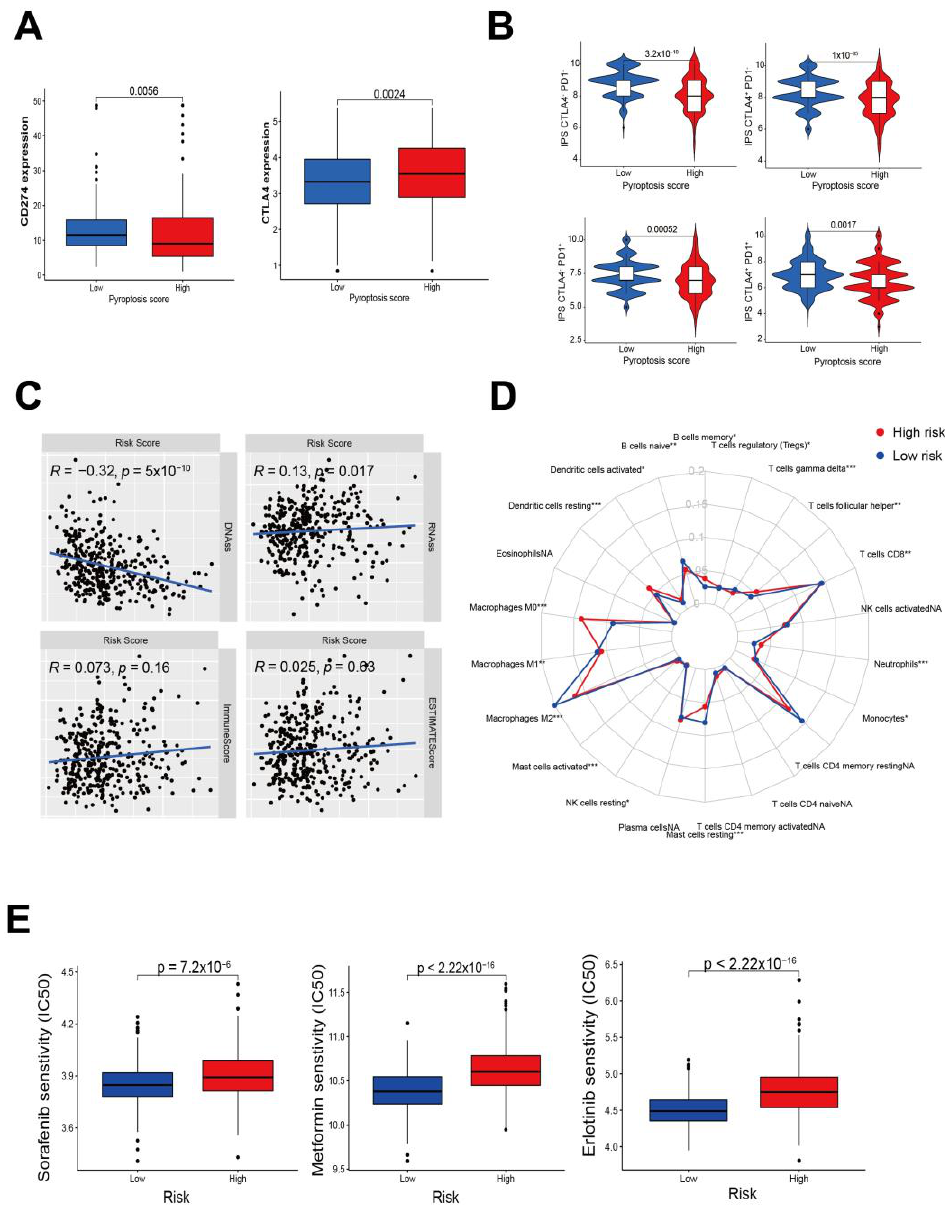
Figure 8. Pyroptosis risk scores in the prediction of immunotherapy. ( A ) Immunological checkpoint CD274 and CTLA4 expression in low- and high-risk groups. ( B ) Immunological checkpoint therapy prediction of risk score in four-CLTA4 and PD1 subtype groups. ( C ) Correlation plot between pyroptosis risk score and DNA stemness score (DNAss), RNA stemness score (RNAss), stromal score, immune score, and ESTMATE score. ( D ) * p < 0.05, ** p < 0.01, *** p < 0.001. Radar plot showing cell infiltration from the CIBERSORT procedure. Each section of the graph represents one of the 22 human cell phenotypes, with each point representing the mean proportion of each cell population in the high-risk (red line) and low-risk groups (blue line). ( E ) Sensitivity analysis of three pharmaceutical therapy in patients at high and low